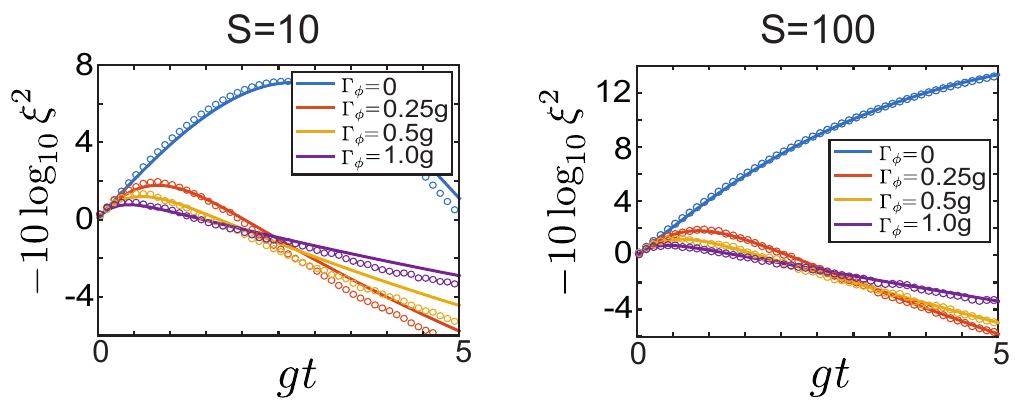
Figure 6: Time evolution of the squeezing parameter ξ for different dephasing rates Γ / g = 0,0.25,0.5,1.0 and for S = 10 and S = 100. The solid lines represent the φ exact results, while circles have been obtained from a stochastic sampling of the Wigner distribution. The system is initialized in the state with all spins pointing down, | S z = − S 〉